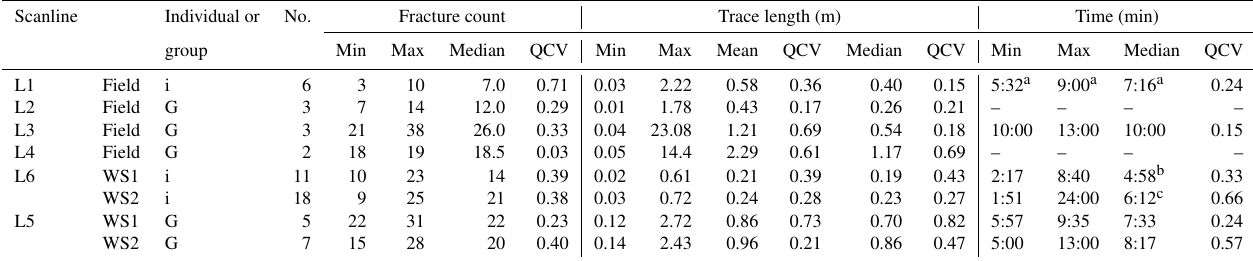
Table 4. Summary table of raw linear scanline results, where i: individual, G: groups, No.: number of participants or groups. Scanline Individual or